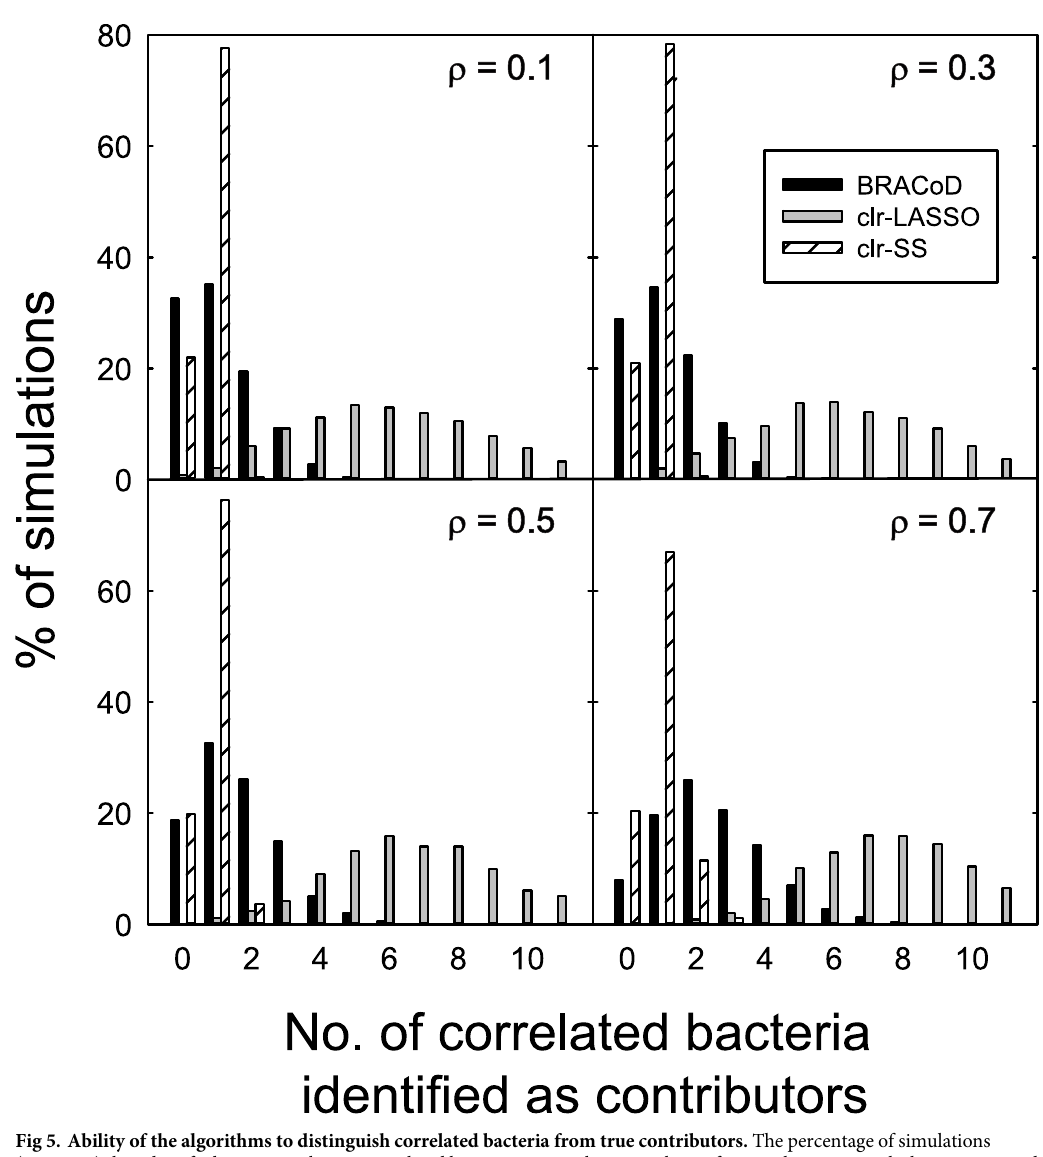
Fig 5. Ability of the algorithms to distinguish correlated bacteria from true contributors. The percentage of simulations (N = 1000) that identified non-contributing correlated bacteria as contributors is shown for correlation strengths between 0.1 and 0.7 ( ρ in the equation: s 2 ¼ r � s � s ; see Simulations section). Contributing bacteria were identified as having ^ p ^ � 0.3. jk j k jk Higher values to the left of each panel indicate a superior ability to discriminate between contributors and non-contributors. Simulated data were constructed with 20 contributors plus 100 non-contributing bacteria. Within the non-contributing bacteria, 20 were chosen as correlated